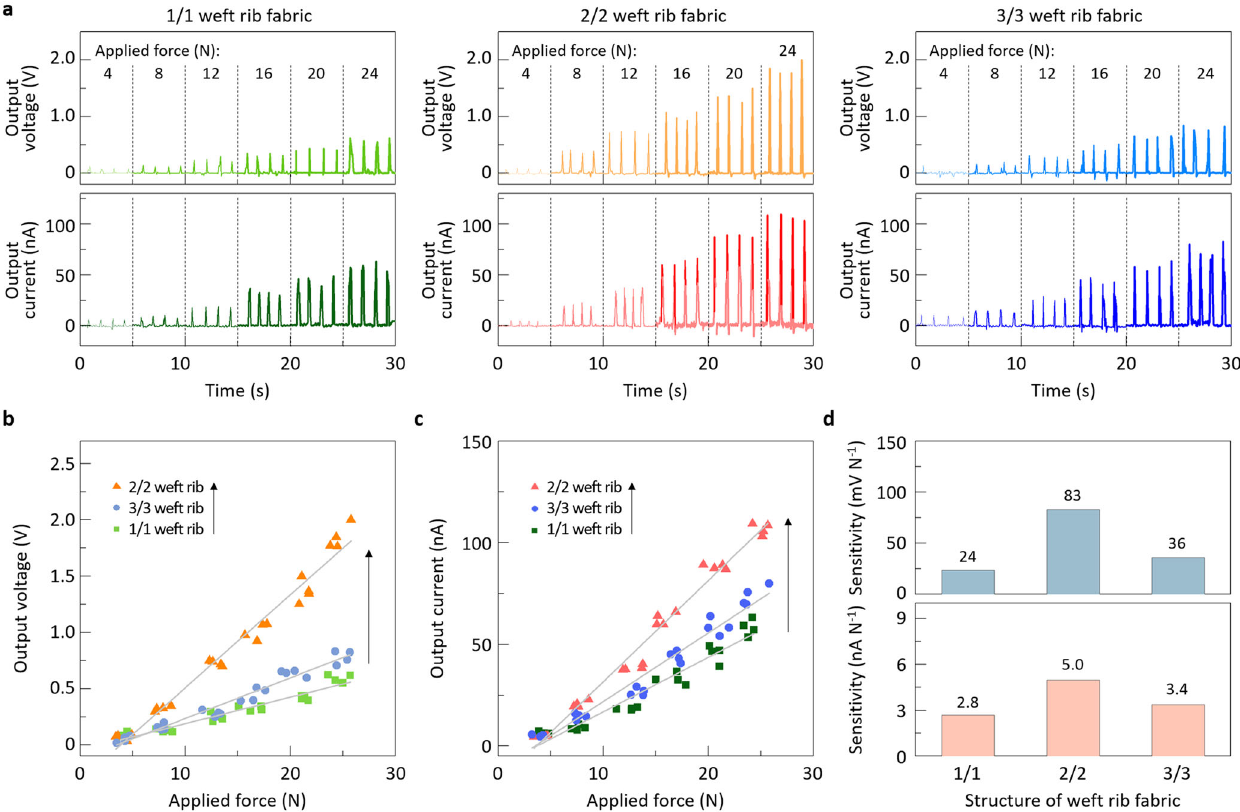
Fig. 3 Electrical performances of the fabric-based pressure sensor. a Output voltage and current generated by fi nger-pressing the generators incorporating 1/1, 2/2, and 3/3 weft rib weave fabrics over the designated regions applied with the measured forces from ~4 N to ~24 N. b , c Plots of peak voltage b and current c as functions of the applied force monitored by a force sensor attached to each type of fabric. d Voltage and current sensitivities measured for the different weave